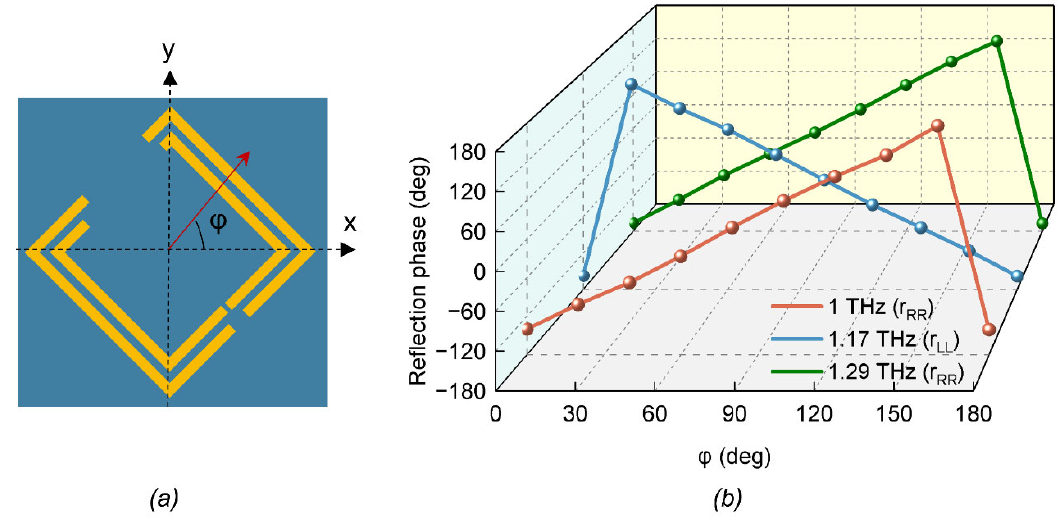
Figure 5. PB phase simulation verification of the T-SRR. ( a ) Schematic of the rotation angle ϕ of the T-SRR unit cell; ( b ) Reflective phase response of the T-SRR varies with the rotation angle ϕ at frequency points of 1, 1.17, and 1.29 THz.